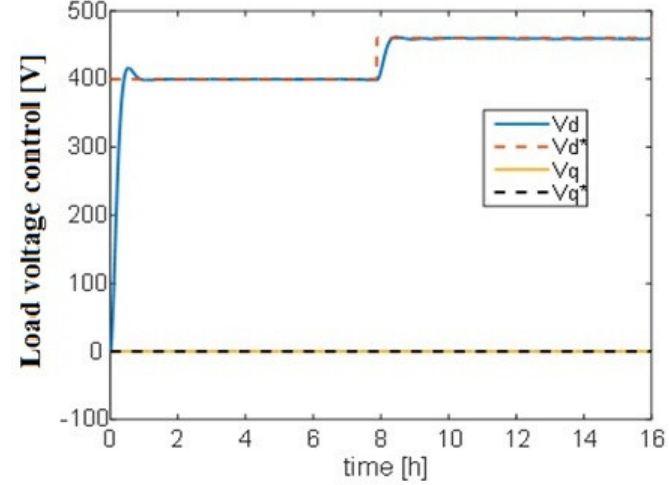
Figure 15. Load voltage control results using an NPC inverter.